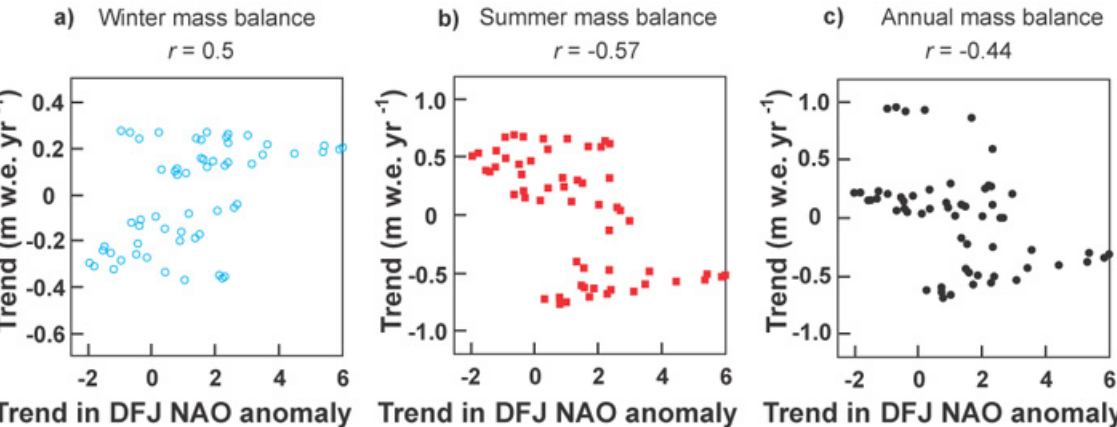
Fig. 7. Correlation between trends in NAO anomalies (7-yr smoothed DFJ) and trends in the three components of Sarennes winter (a) , summer (b) , and annual (c) mass balance provided by the variance analysis.